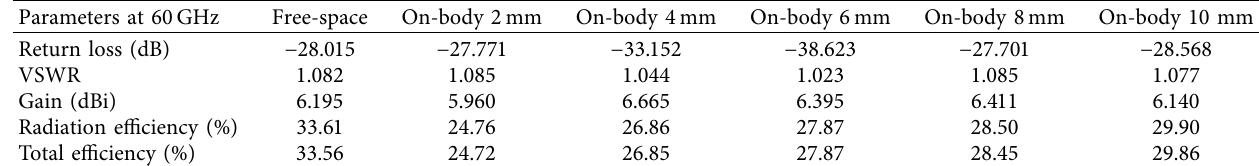
Table 10: Array 4 on-body results at different gap distances.